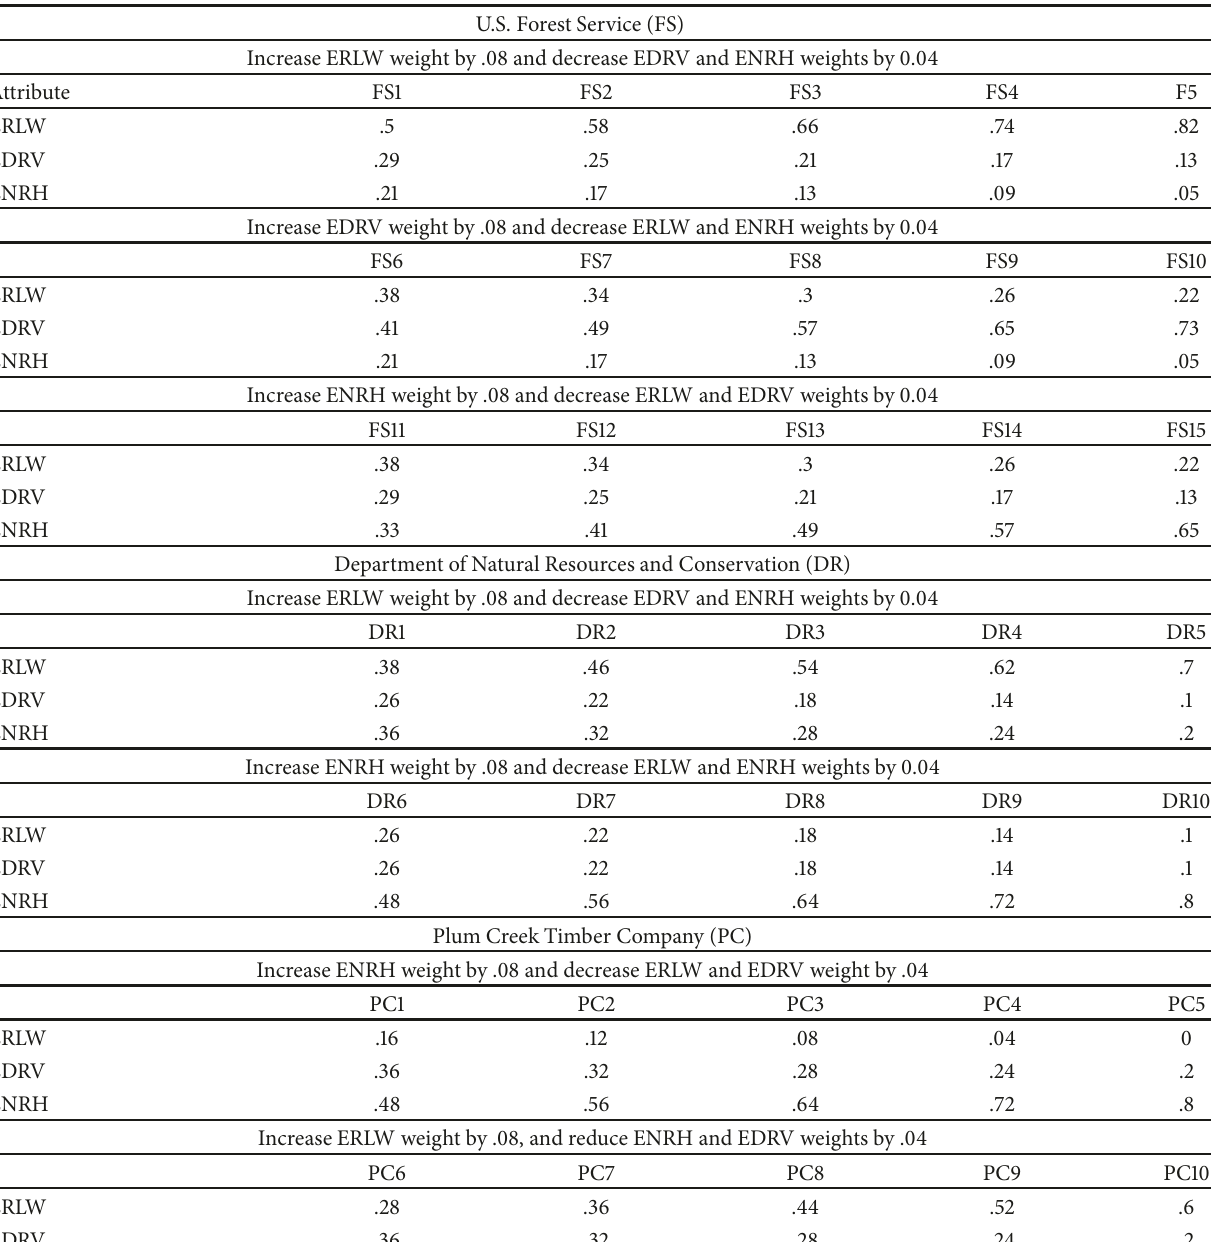
Table 2: Attribute weight scenarios for ERLW, EDRV, and